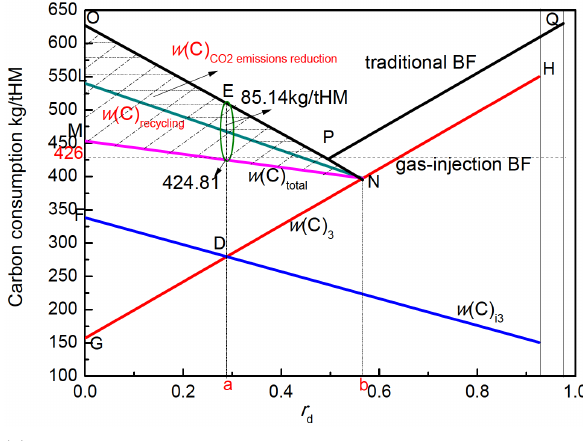
MNH and is substantially lower than that in a traditional BF (polylines OPQ). In addition, the hatch area represents the carbon recycling potential, and the upper portion is the CO abatement potential. In addition, detailed infor- 2 mation for w (C) is shown in Figure 3 (b). Although recycling w (C) total reaches a minimum when r d = b, w (C) recycling is 0, and the gas utilization is lower. Therefore, the direct reduc- tion degree should be lower than b to exploit the